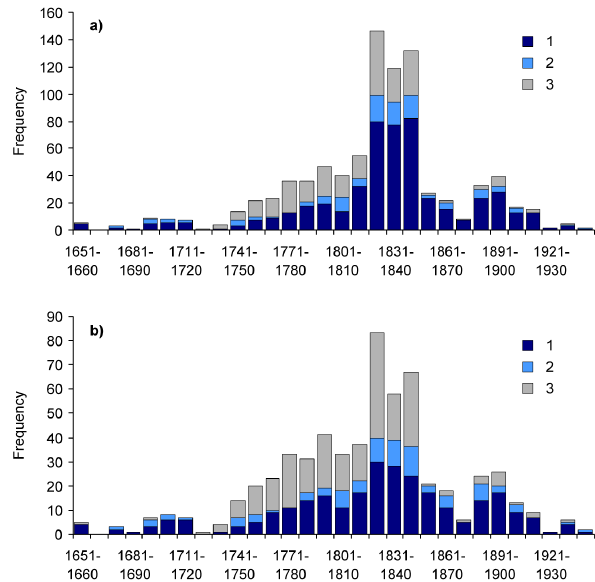
Figure 4. Decadal numbers of (a) taxation records related to floods and (b) flood events derived from taxation records in South Moravia, arranged by flood (1), flash flood (2) and inundation